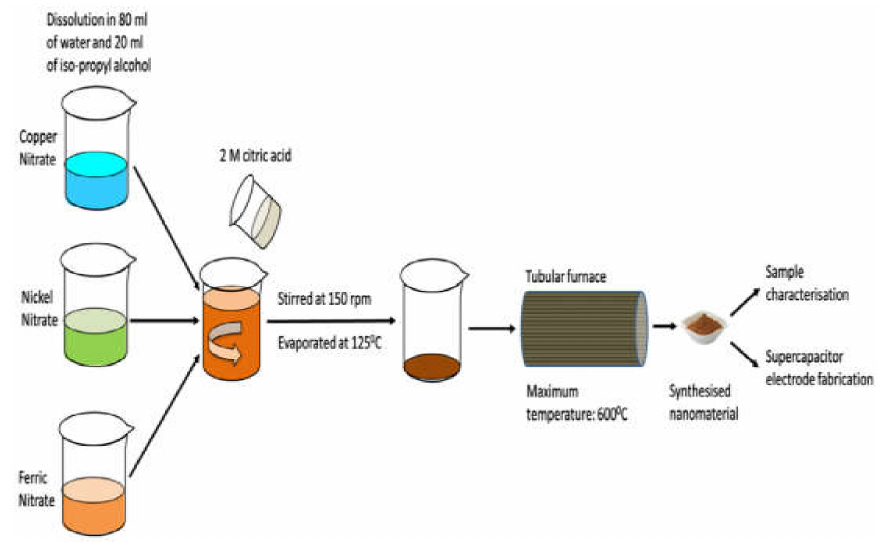
Figure 6. Sol-gel process for the preparation of (MTTMF) as electrode materials for supercapacitors. Reproduced with permission from [134]. Elsevier,